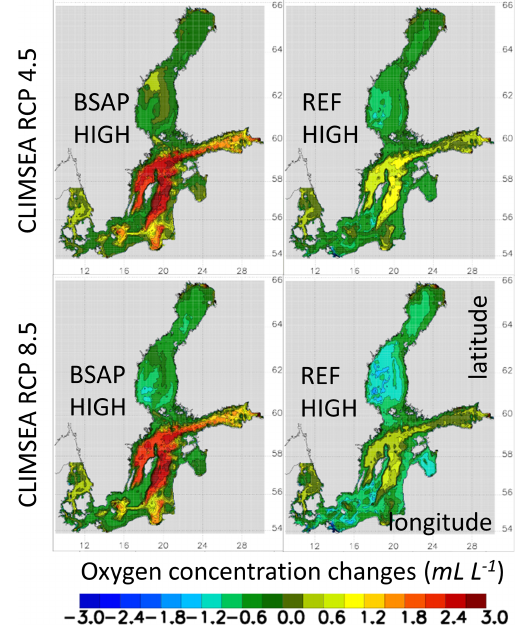
Figure 22. As in Fig. 21 but for CLIMSEA RCP4.5 (upper panels) and CLIMSEA RCP8.5 (lower panels) under a high sea level rise scenario, i.e. 1.26m (RCP4.5) and 2.34m (RCP8.5). Left and right columns show the BSAP and REF scenarios, respectively. (Source: Meier et al., 2021; their Fig. 5 distributed under the terms of the Cre- ative Commons CC-BY 4.0 License, http://creativecommons.org/ licenses/by/4.0/, last access: 6 January 2022.)